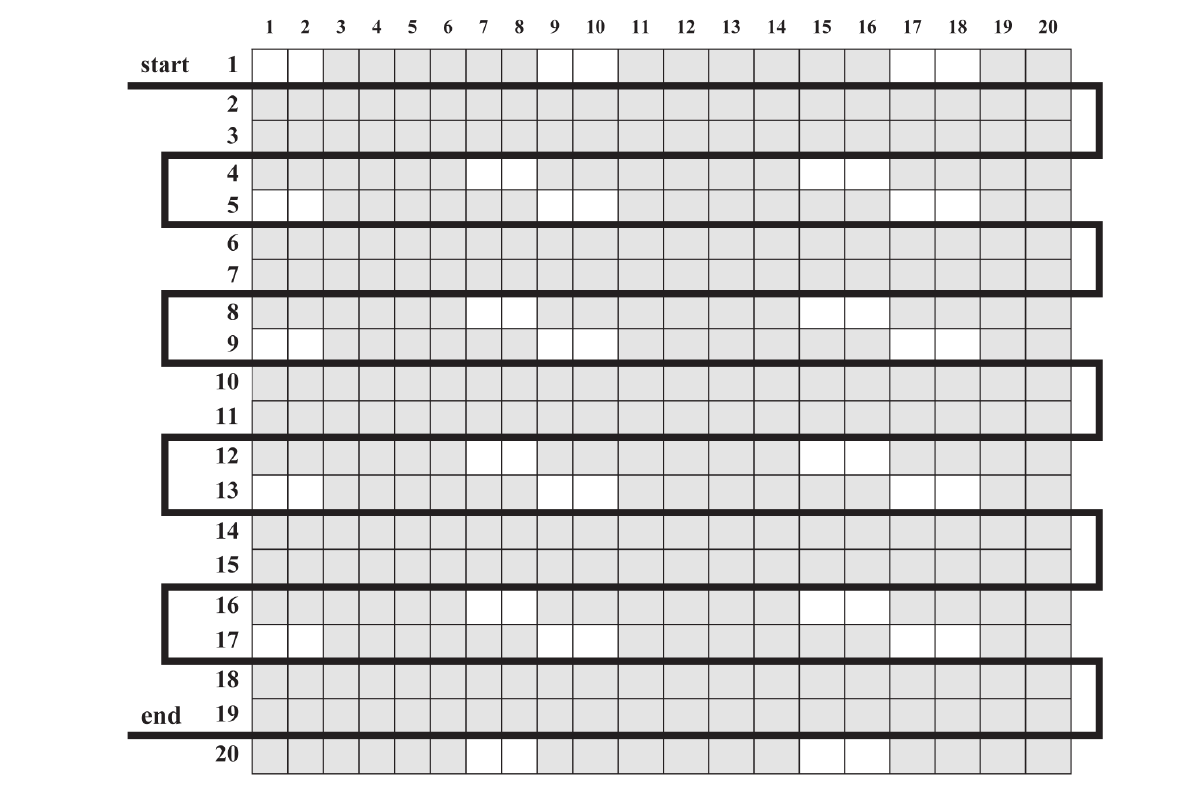
Figure 1. Scheme followed for sampling (Gottwald and hughes [2000] with modifications): white squares indicate sampled trees, grey squares are trees not